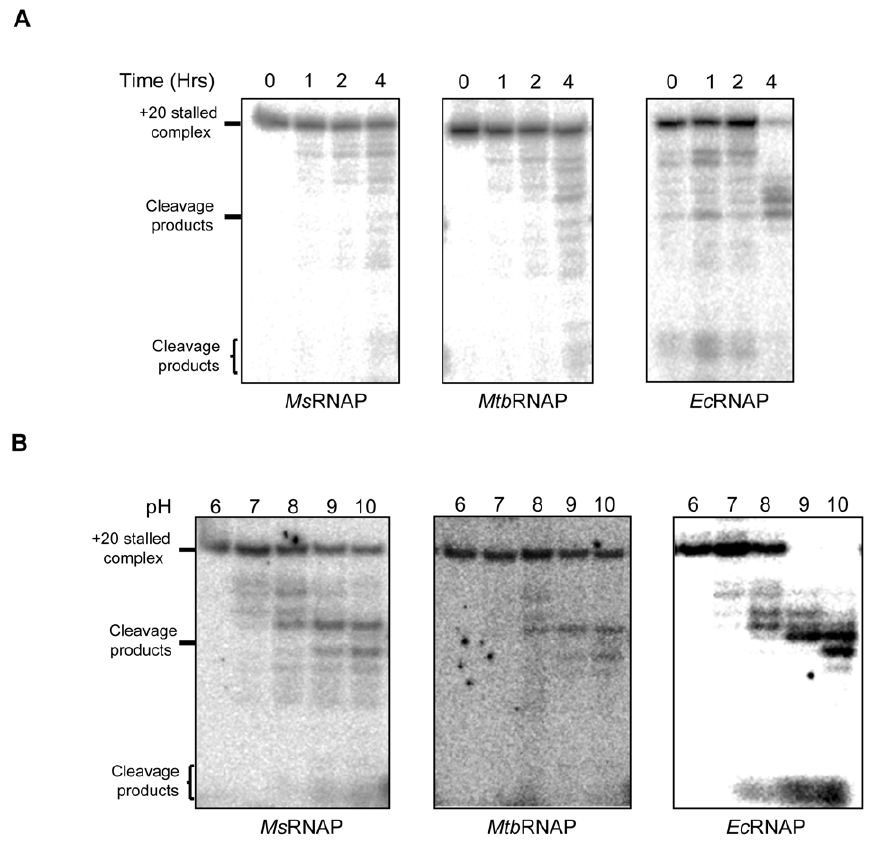
Figure 1. (A) Intrinsic transcript cleavage property of RNAP. Stalled elongation complexes bearing the 20 mer transcript were generated with M. smegmatis ( Ms ), M. tuberculosis ( Mtb ) and E. coli ( Ec ) RNAP respectively. The complexes were incubated for a prolonged time (1–4 hrs) in transcription buffer (pH 7.5), followed by resolving the cleavage products on 20% urea-PAGE. (B) pH-induced transcript-cleavage activity of RNAP. The gels show cleaved RNA generated from the 20 mer ternary complexes formed by Ms , Mtb and Ec RNAP in buffers of pH 6.0 to